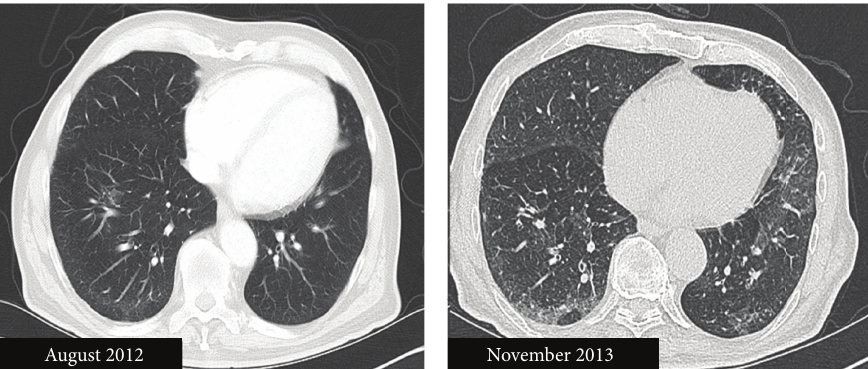
Figure 1: Computed tomography image of the patient’s lungs prior to treatment with chlorambucil (August 2012) and after diagnosis of pneumonitis (high-resolution scan, November 2013), demonstrating interval development of interlobular septal thickening more prominent in the periphery of the right lung, suggestive of interstitial lung